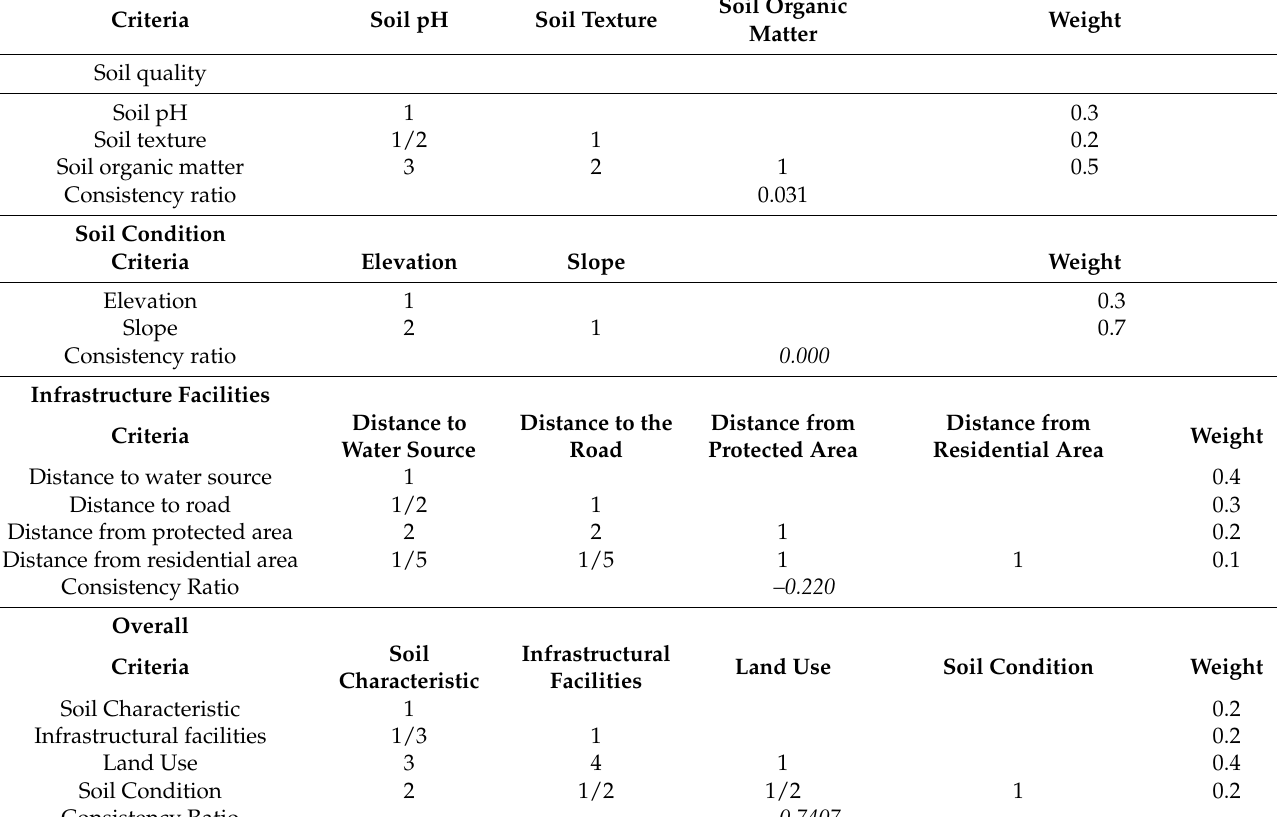
Table 4. Pairwise comparison matrix and the weight assigned for each criterion.